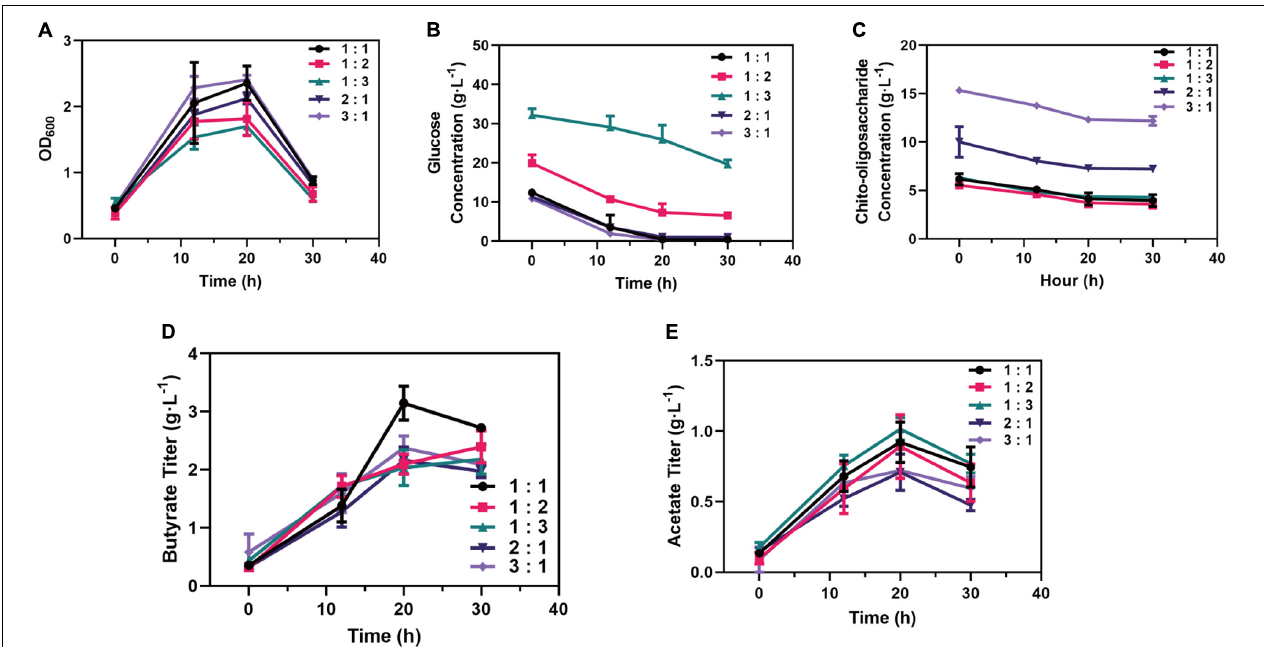
FIGURE 6 | Optimizing added strategy of the proportion (C-mole) of chito-oligosaccharide and glucose. (A) Growth performance of strains in medium supplemented with different proportions of carbon sources. (B) Consumption of glucose in medium supplemented with different proportions of carbon sources. (C) Consumption of chito-oligosaccharide in medium supplemented with different proportions of carbon sources. (D) Production of butyrate supplemented with different proportions of carbon sources. (E) Production of acetate supplemented with different proportions of carbon